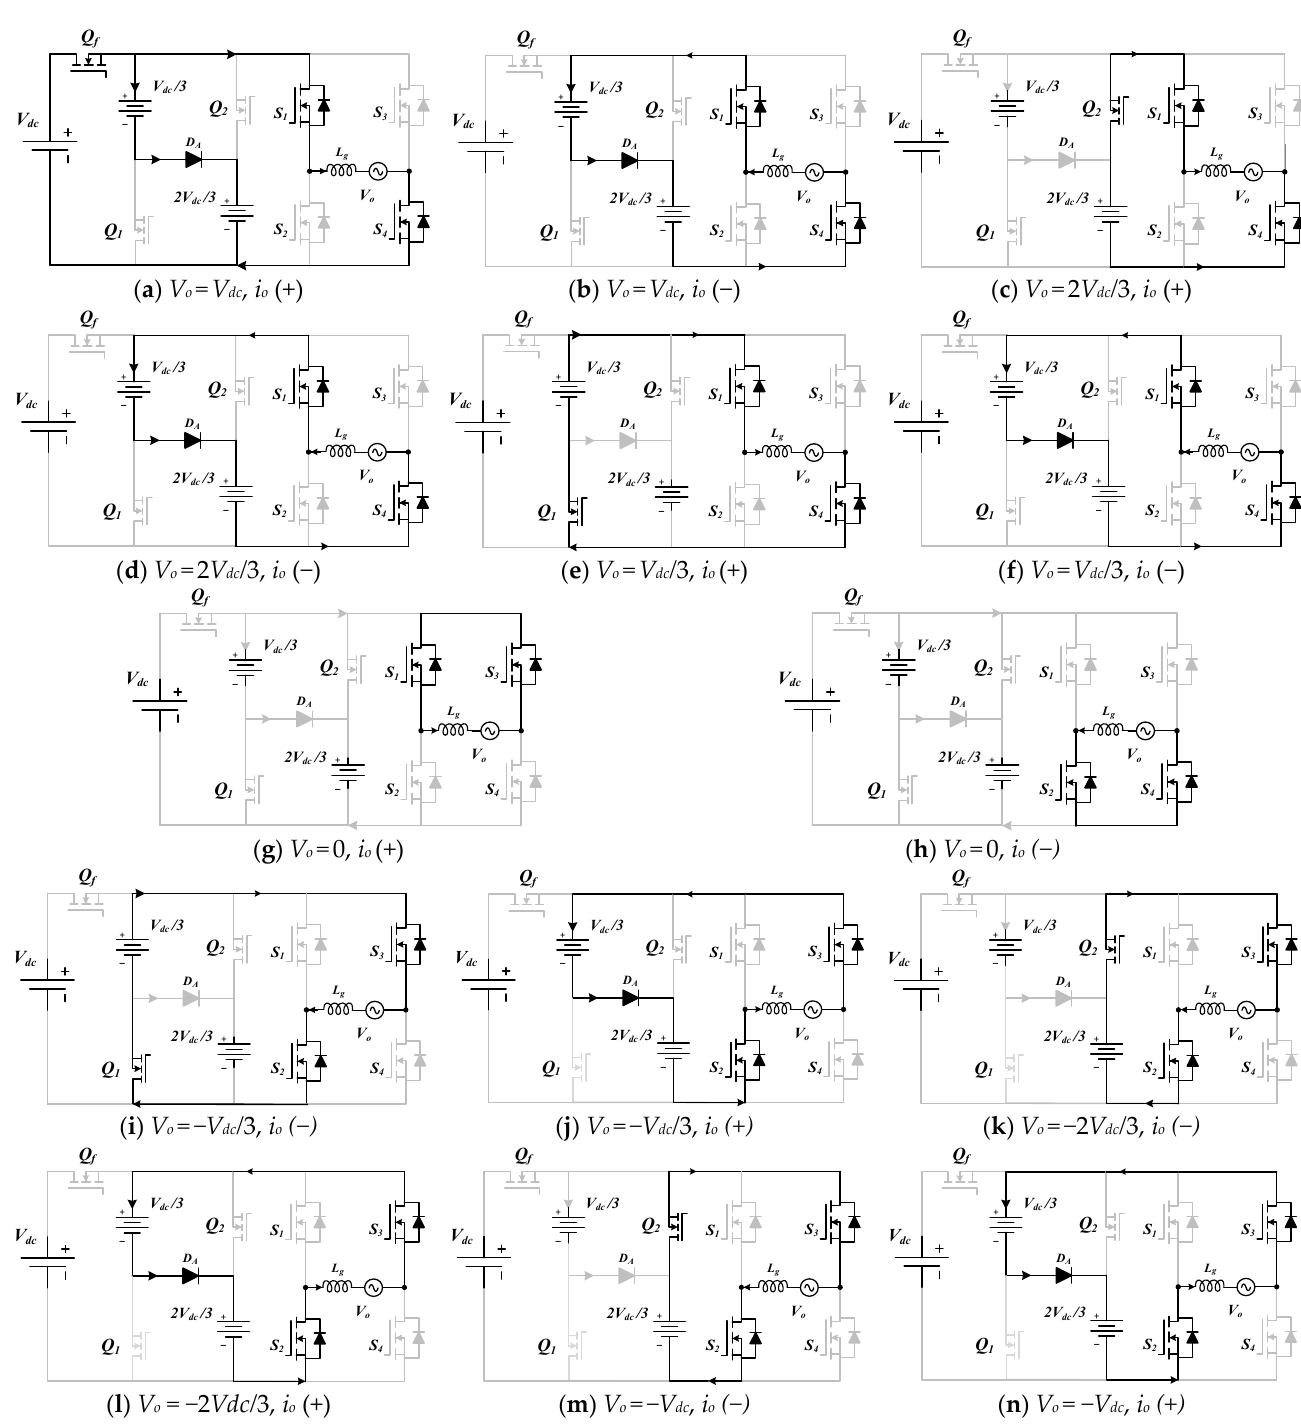
Figure 3. Operational modes of the 7-level inverter to synthesize the multilevel output-voltage.